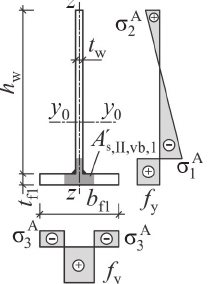
Fig. 8. analytical calculation of area of HaZ and residual stresses for T profile